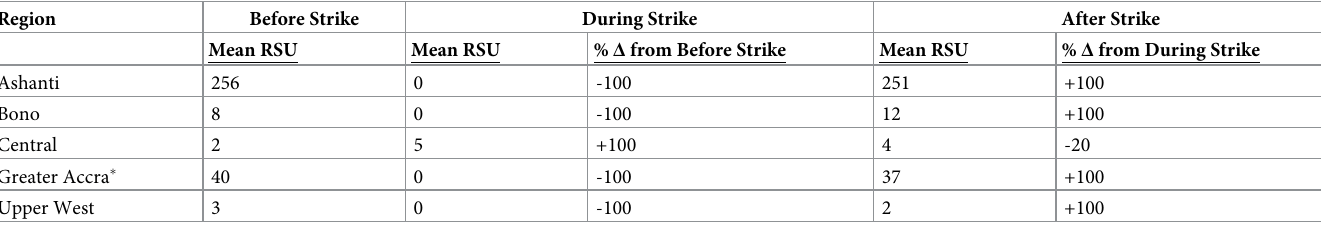
Table 11. Percentage change in reproductive service use (RSU) during and after strike. Region Before